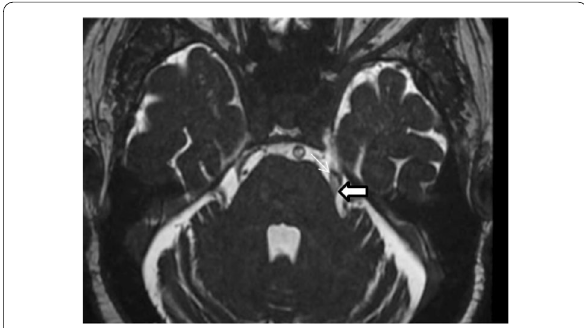
Fig. 7 Axial FIESTA showing vascular loop (thin arrow) away from root entry zone touching the left trigeminal nerve (thick arrow)